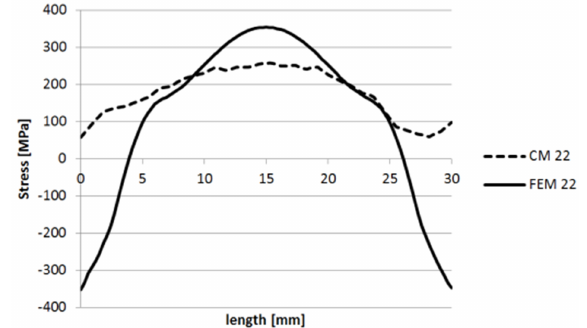
Figure 49. Stress levels in 22 direction along the CD line segment.